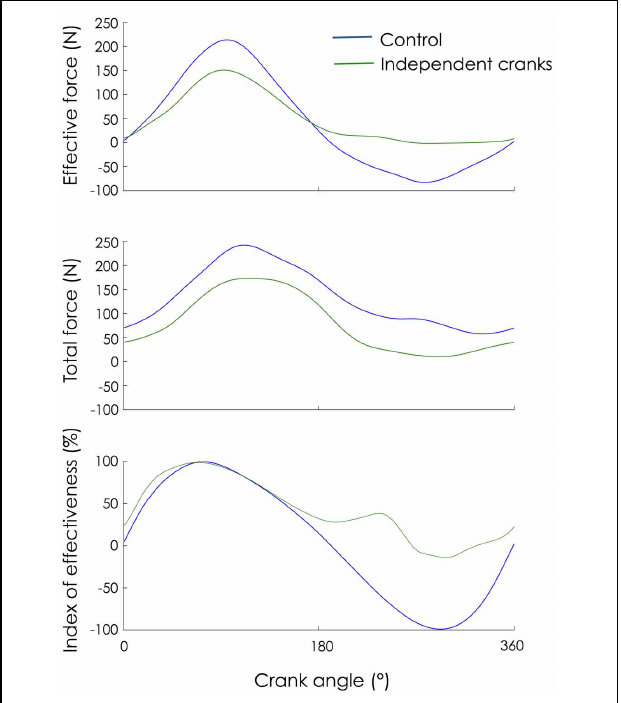
FIGURE 1 | Change in mechanical patterns. Mechanical patterns from the left pedal were averaged across 30 consecutive pedaling cycles and expressed as a function of the left crank angle as it rotated from the highest pedal position (0 ◦ ) to the lowest pedal position (180 ◦ ) and back to the highest